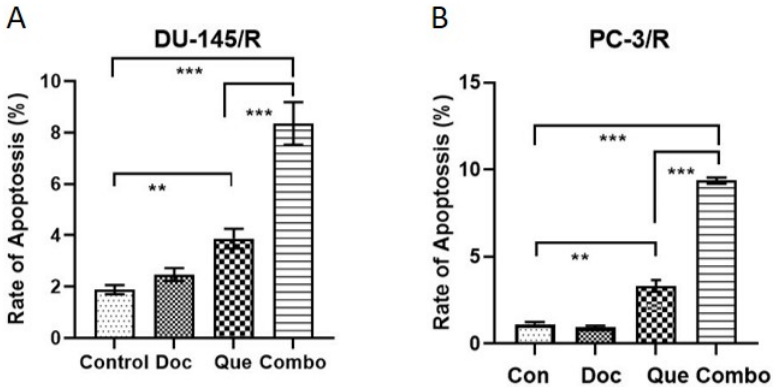
Figure 7. Induction of apoptosis by quercetin in docetaxel-resistant cells. The percentage (%) of cell distribution ( A ) of DU-145/R cells and the percentage (%) of cell distribution ( B ) of PC-3/R cells 24 h after treatment with designated drugs or vehicle control, as determined by Annexin V-7AAD and PE staining. Data are presented as mean ± SD. ** p < 0.01 *** p < 0.001. The experiments were performed at least three times in triplicate.